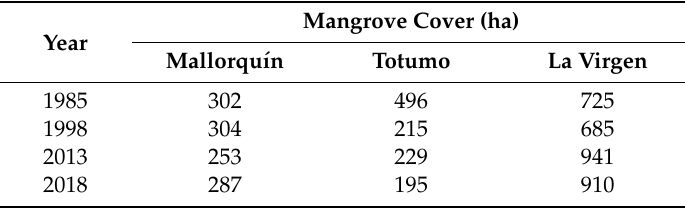
Table 2. Variation of the mangrove forest cover (ha) in the Mallorqu í n, Totumo, and La Virgen